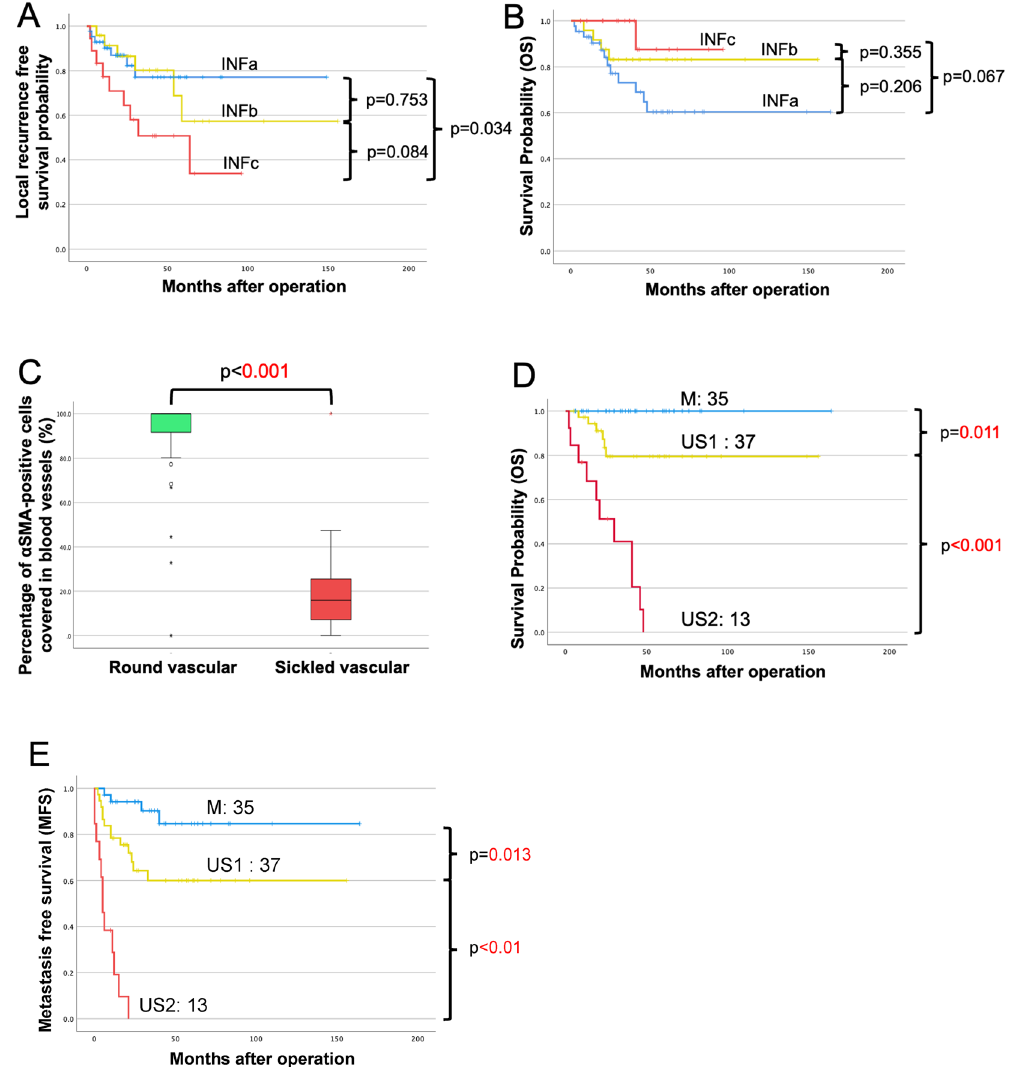
Figure 2. ( A ) Kaplan–Meier analysis of local recurrence and INF. Local recurrence tended to be more frequent in INFc cases than in INFa cases. ( B ) Kaplan–Meier analysis of overall survival and INF. The INFa group showed poorer prognoses than the INFc group. ( C ) Box-and whisker graph of αSMA-positive cells associated with 42 round and 42 sickle-shaped blood vessels. There was a significant difference in the percentage of αSMA